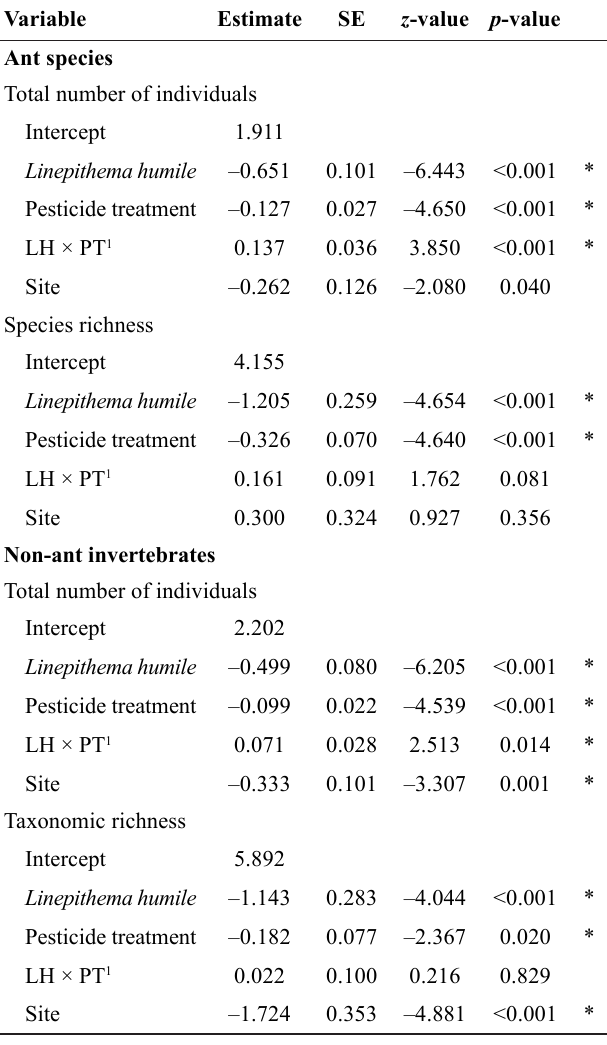
Table 2. Results of generalized linear models examining the effects of Linepithema humile , pesticide treatment, their interaction, and site on total number of individuals and species or taxonomic richness per